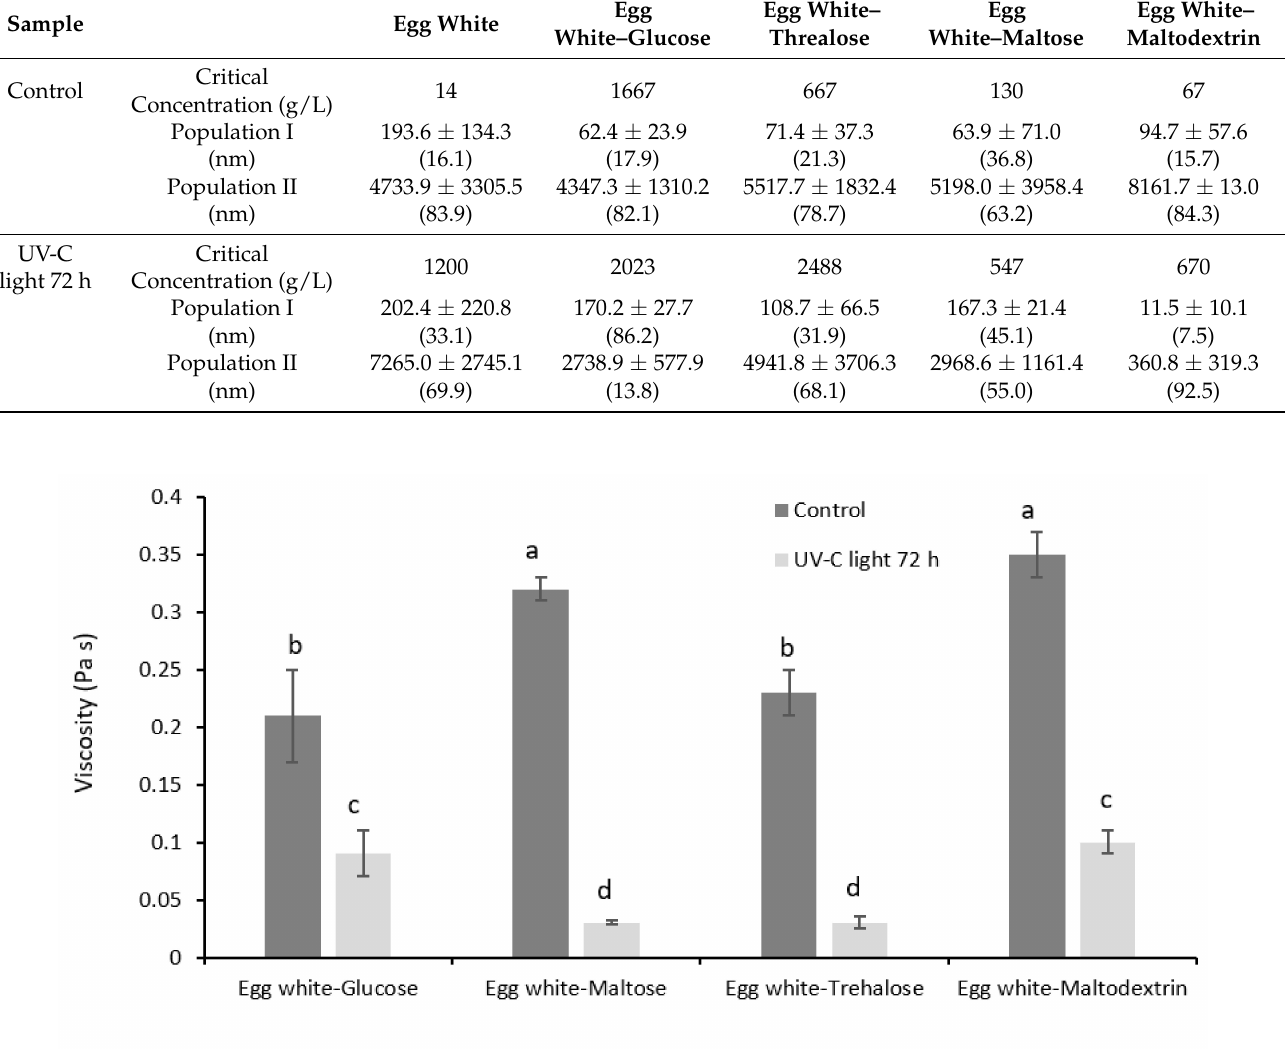
Figure 1. Apparent viscosity of aqueous suspensions of egg white and egg white–sugar mixtures before and after exposure to UV-C light for 72 h. a–d : Means indicated by different letters are significantly different ( p < 0.05). Error bars represent the Standard